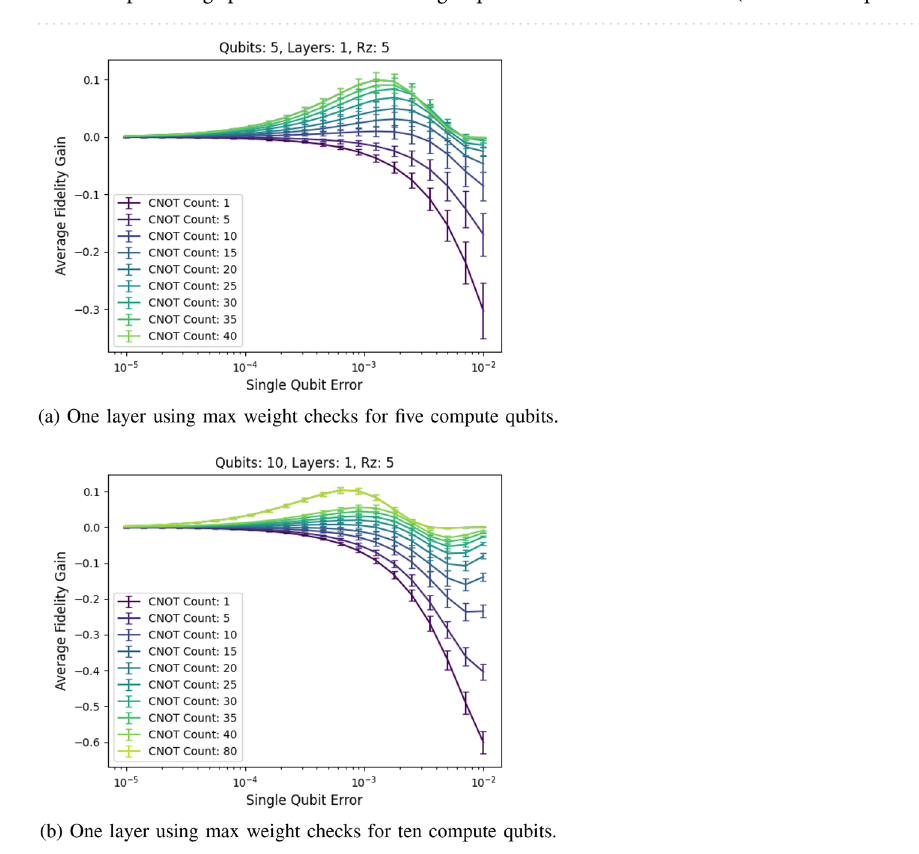
Figure 17. Max weight checks. The high-weight checks introduce a lot of noise compared with the low-weight method, as shown in the large negative fidelity at a high single-qubit error